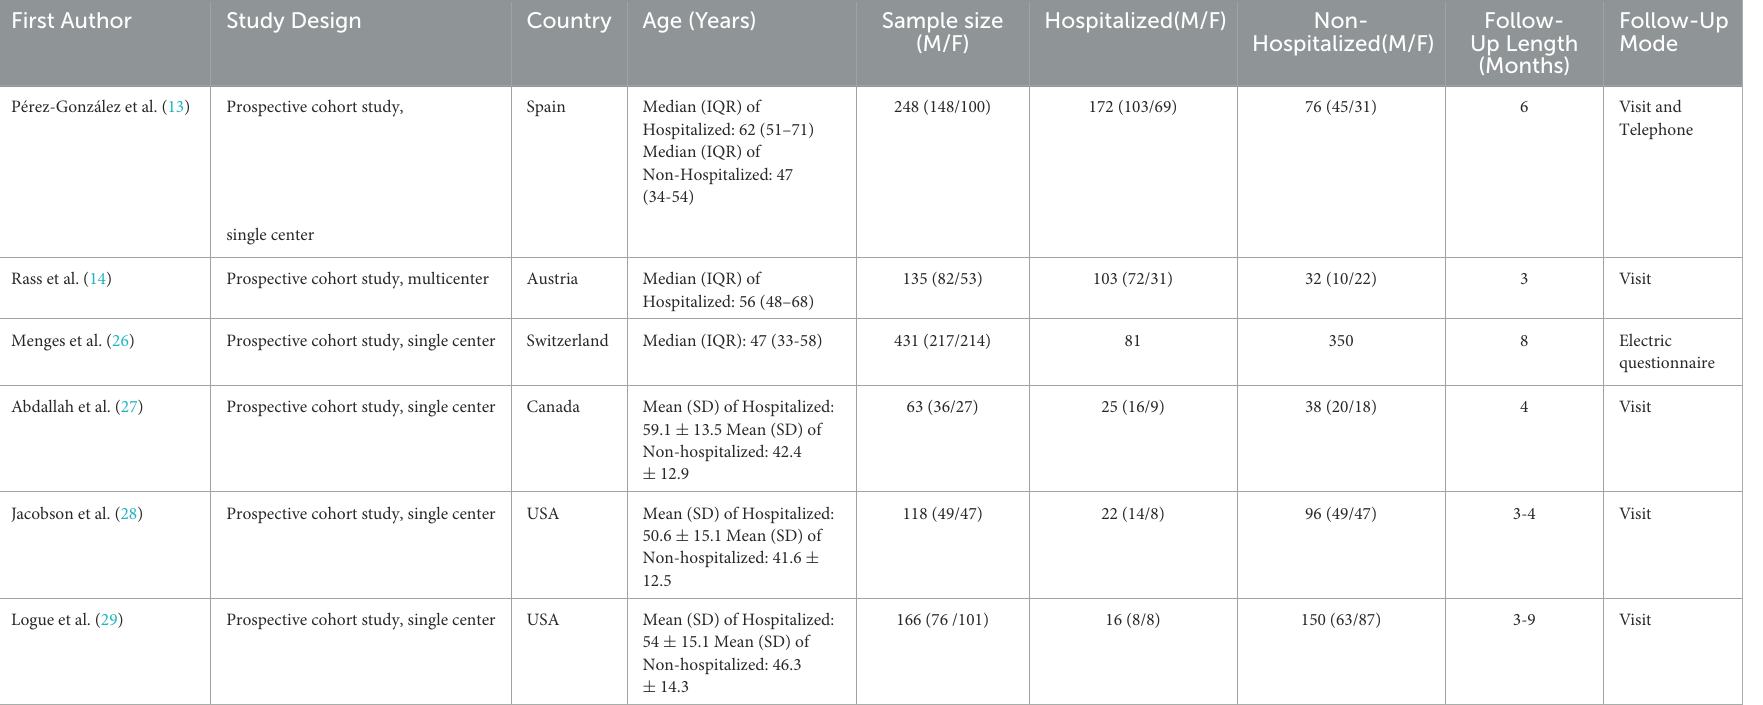
TABLE 1 The characteristics of included